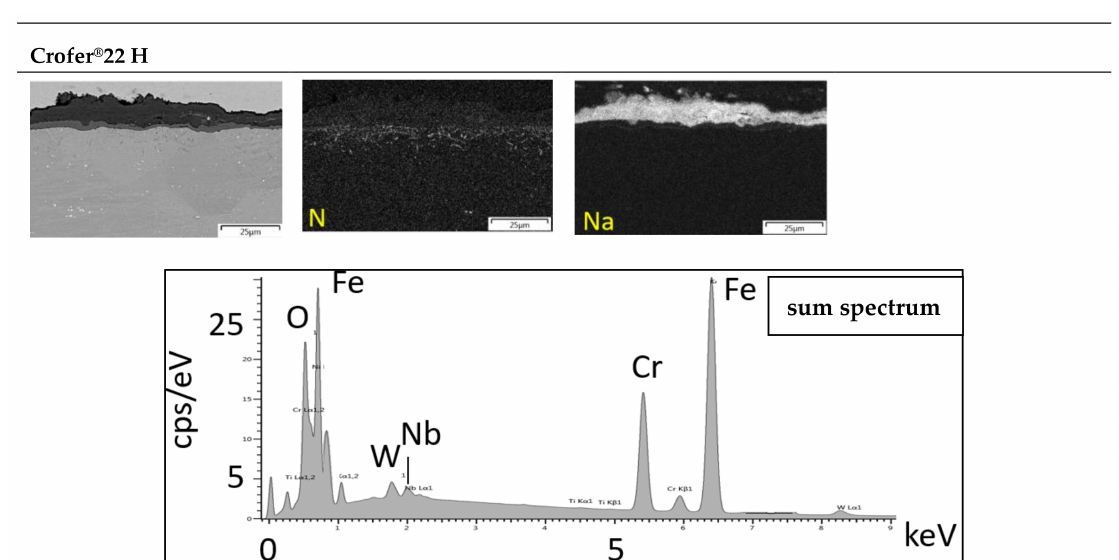
Figure 5. EDX element mappings of the sample cross-sections after 2042 h of discontinuous corrosion testing in solar salt at 600 ◦ C with respective EDX sum